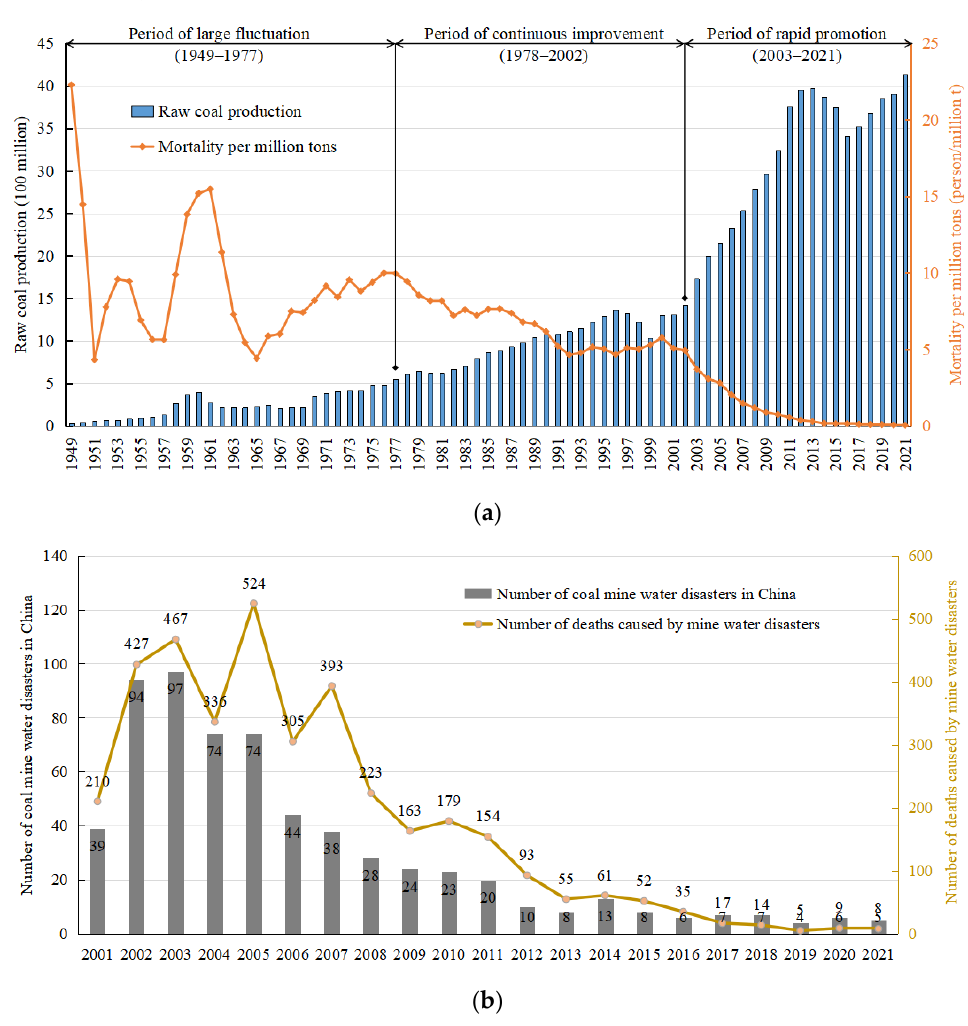
Figure 1. Development process of coal mine safety situation in China: ( a ) statistics of raw coal production and mortality per million tons (1949–2021); ( b ) statistics of coal mine water disasters and casualties (2001–2021).